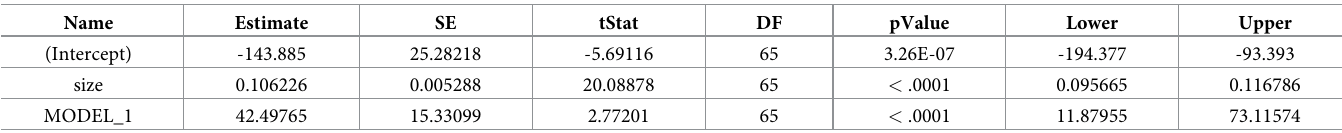
Table 7. The fixed effects coefficients of the model explaining the testing time in terms of the HPN+2opt/GPN+2opt and the problem size.